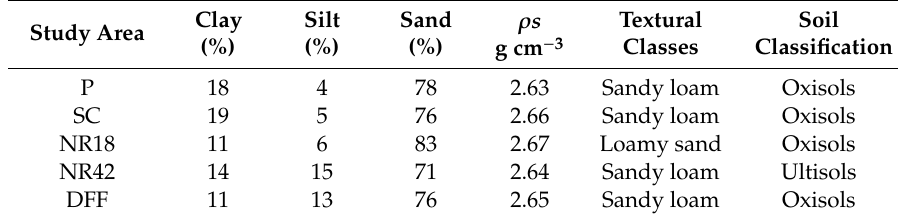
DFF: Degraded forest fragment.